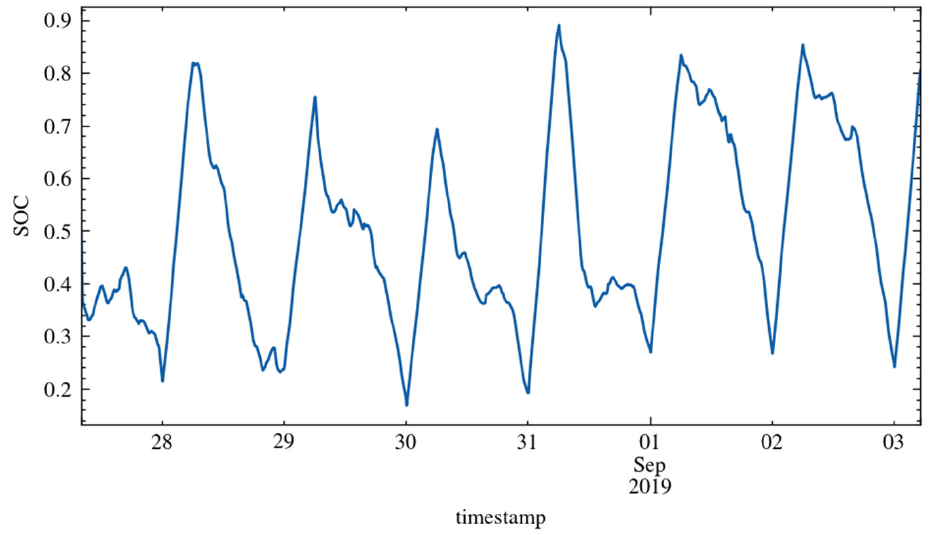
Figure 11. Battery SOC profile in Scenario 2.